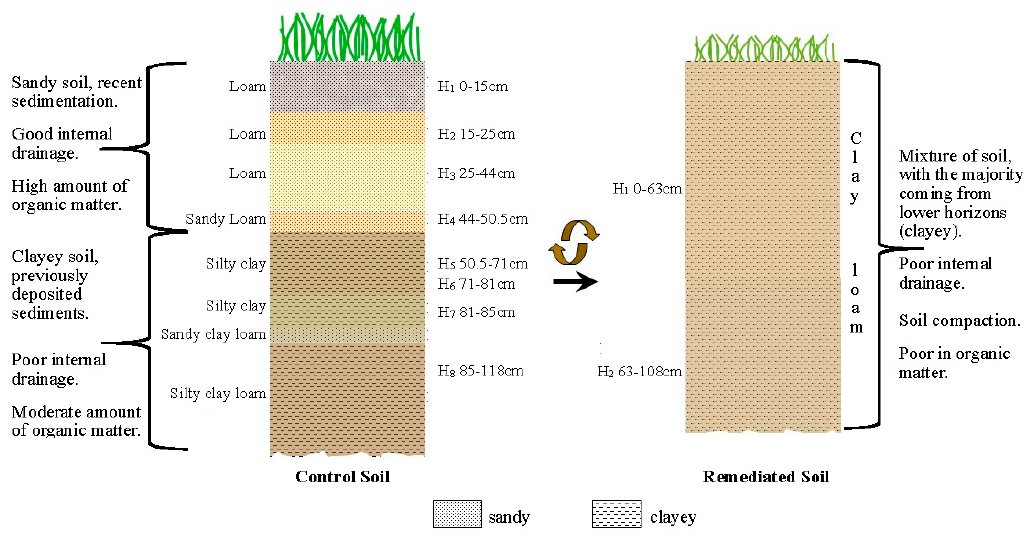
Figure 7. Pre- and post-remediated soil profile display.